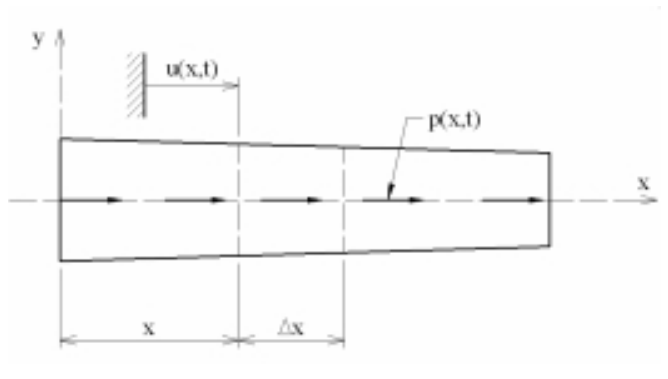
Fig. 1. Straight bar with axial deformation.